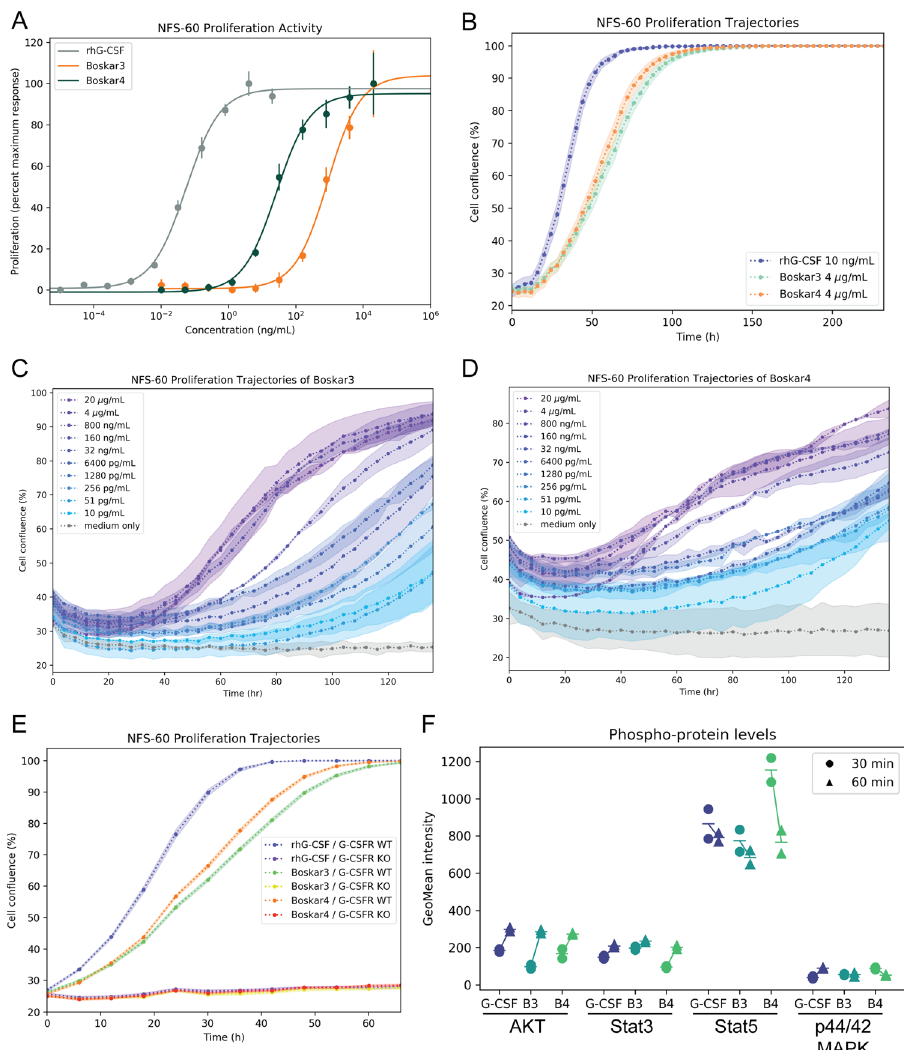
Fig. 2 The designs display potent and speci fi c activity in cell-based assays. A Dose – response curves of NFS-60 proliferation upon 48 h treatment with Filgrastim (rhG-GCSF), Boskar3, or Boskar4. Datapoints and error bars represent mean ± standard deviations of three biologically independent replicates. B Time-dependent proliferation trajectory of surface-immobilised NFS-60 cells over a 10-day treatment. Data points and shades represent mean and standard deviation values of three biologically independent replicates. Experiments were performed three times in triplicates. Data of one representative experiment is shown. C , D Dose- and time-dependent proliferation trajectories over a 5-day treatment of free- fl oating NFS-60 cells, under the in fl uence of Boskar3 and Boskar4 treatments, respectively. Data points and shades represent mean and standard deviation values of three biologically independent replicates. E G-CSFR-de fi cient primary stem cells (G-CSFR KO), show abolished proliferative responses to either rhG-CSF or the designs. Experiment was performed twice in triplicates. Data points and shades represent mean and standard deviation values of three biologically independent replicates. F Intracellular levels of phospho-AKT (Thr308), phospho-ERK1/2 (p44/42 MAPK), phospho-STAT3 (Tyr705), and phospho-STAT5 (Tyr694) in CD34 + HSPCs treated with rhG-CSF or the designs (see the “ Methods ” section). Geometric mean of the expression intensity of each phospho-protein (GeoMean intensity) is shown on the y -axis. The experiment was performed rhG-CSF, Boskar3 or Boskar4 (Fig. 2E). These data demonstrate that the designed proteins act via G-CSFR.